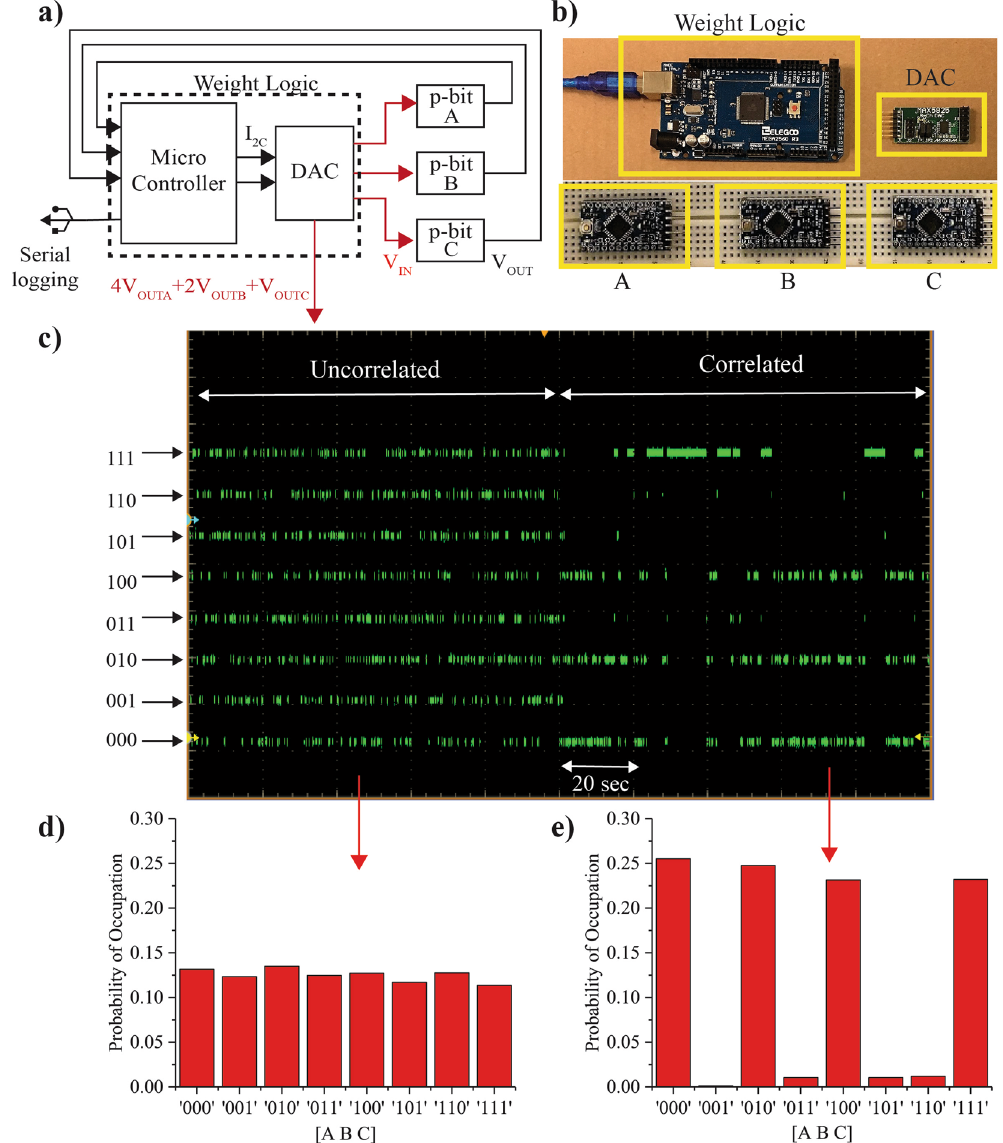
Figure 2. AND gate constructed from 3 p-bits. The block diagram and the schematic of an AND gate constructed using 3 p-bits are shown in ( a ) and ( b ). The electrical wires connecting the components are not shown for clarity. A weight logic block is used to correlate the p-bits as detailed in Algorithm 2. The output voltages of the 3 p-bits A, B and C are combined to form an artificial node 4 × A + 2 × B + C, which is set using the DAC and is used to monitor the state of the system as shown in ( c ). As the system is left uncorrelated, it goes through all possible 8 states of the artificial node with approximately equal probability. When the system is correlated using an I 0 = 0.8, it visits the lines of the truth table with approximately equal probability. This is also seen by the steady-state statistics of the two cases presented in ( d ) and ( e